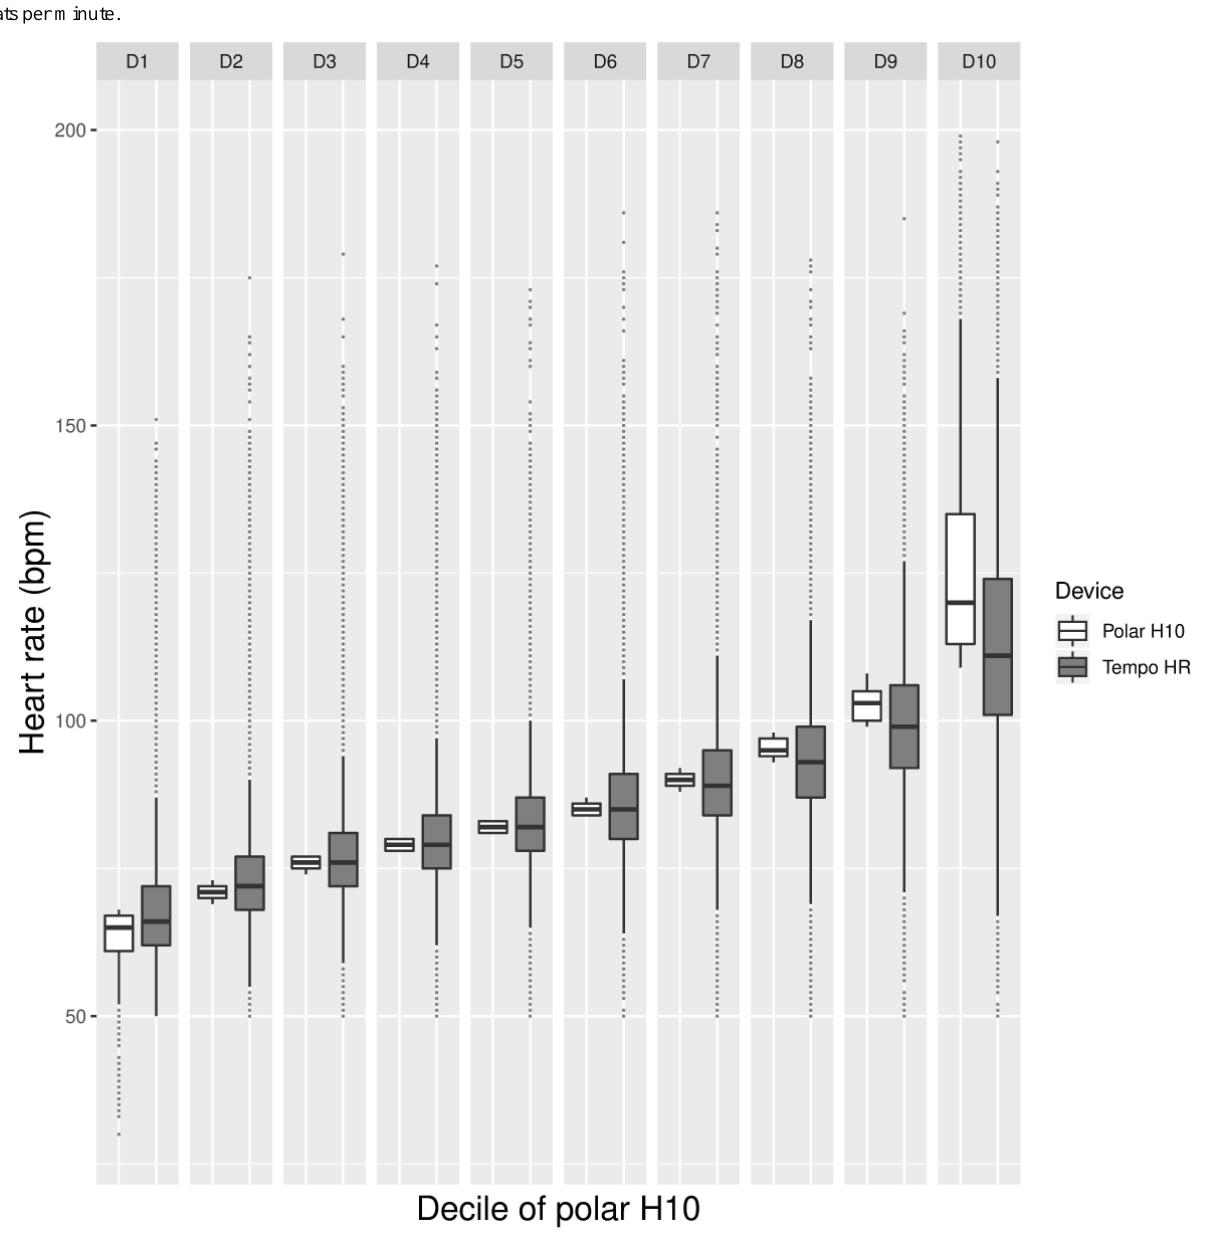
Figure 7. Free-living phase: box plot providing by-decile comparisons of mean Polar H10 (white) and Tempo HR HR data (gray). HR: heart rate; bpm: beats per